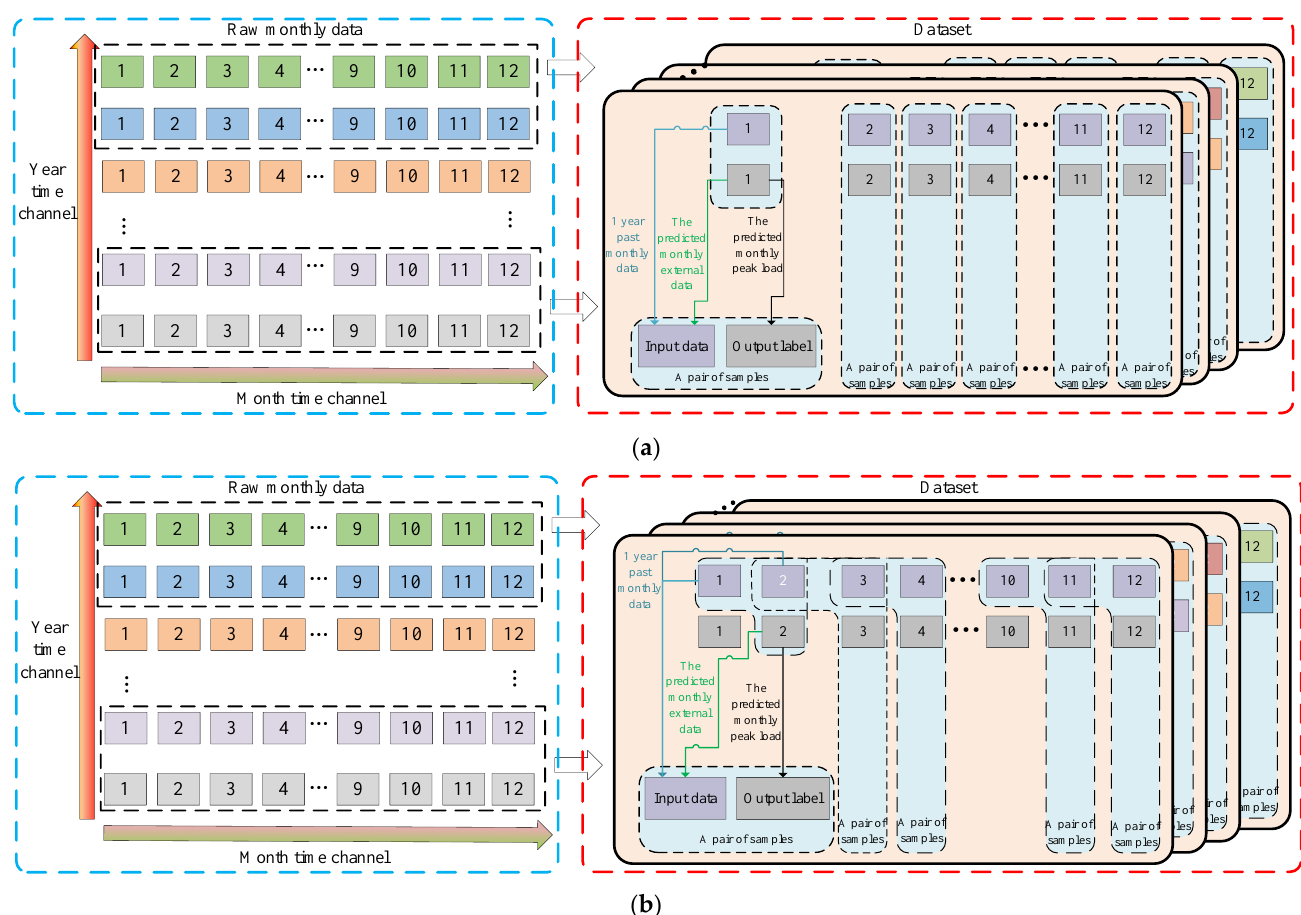
Figure 9. Two methods of constructing time-series data: ( a ) construction of time-series data with a year time channel length of one; ( b ) construction of time-series data with a month time-channel length of two.